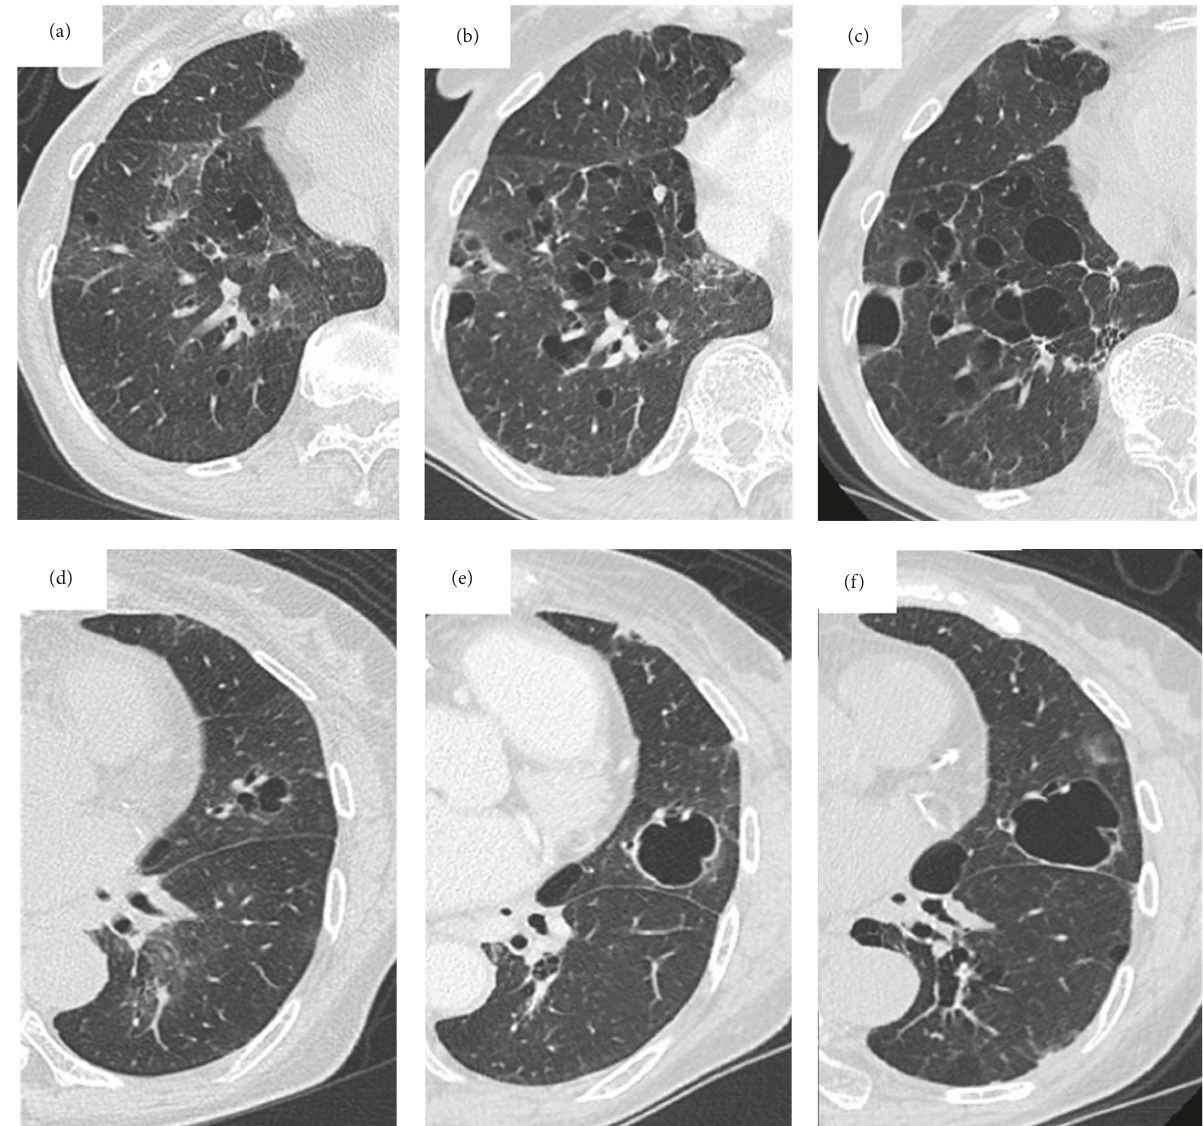
Figure 3: Surveillance chest computed tomography in a 72-year-old woman with Sj ¨ ogren syndrome and pulmonary amyloidosis after 6 years of follow-up. The cystic lung lesions gradually increased in size and number after 6 years. (a–c) The right lower lobe and (d–f) the left upper and lower lobes are shown. (a) and (d) are images taken upon the time of diagnosis, (b) and (e) are images taken after 3 years, and (c) and (f) are images taken after 6